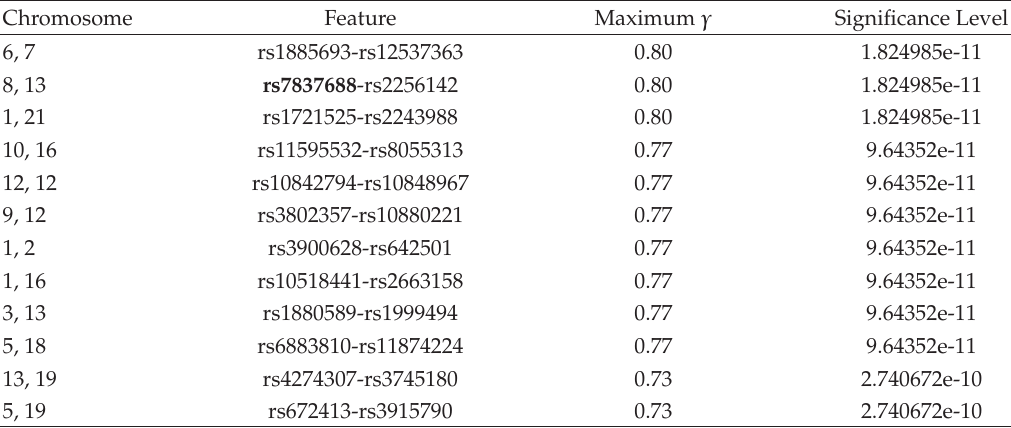
Table 1: Features associated with prostate cancer from the analysis of CGEMS data (cid:3) “rsXXX” denotes SNP reference (cid:4)